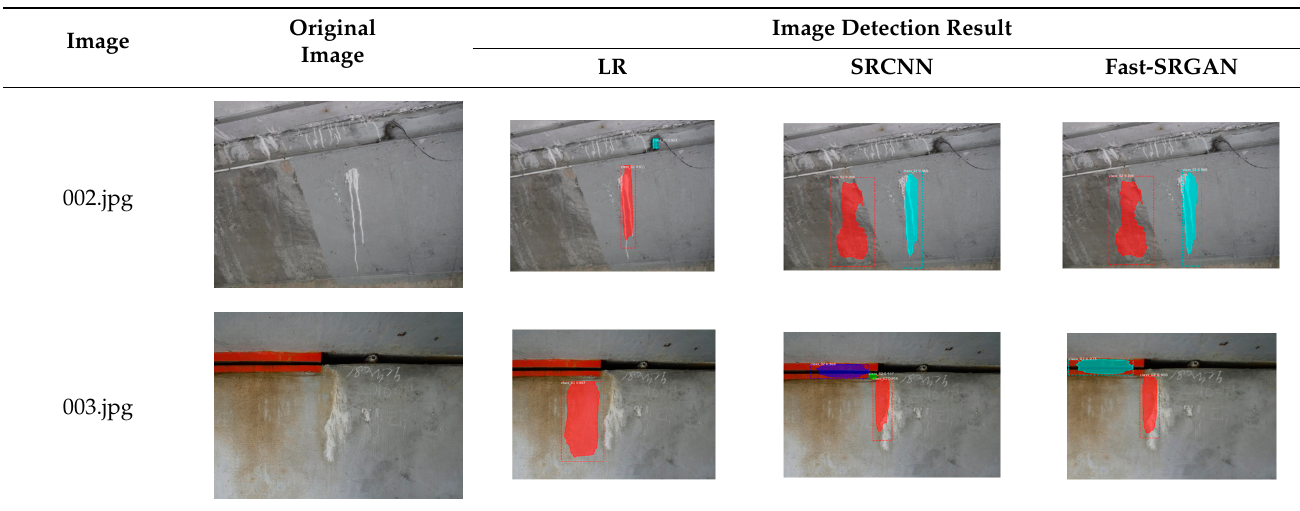
Table 6. Efflorescence object identification result.